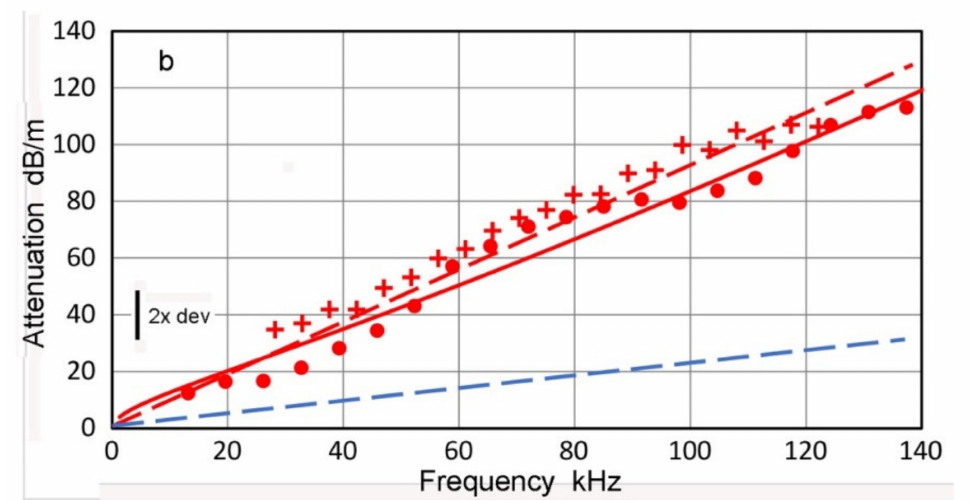
Figure 16. ( a ) Observed α –S o values for 4.3-mm PVC plate along with the calculated attenuation and dashed lines for α L and α T . Two test series are plotted using blue symbols. Both used Olympus V101 Tx and KRN-BB-PC Rx, with short-pulse excitation. Vertical bar shows 2 × dev. ( b ) Observed α –A o values for 4.3-mm PVC plate along with the calculated attenuation and dashed lines for α and α T . Both series are plotted using red symbols and used NDT C16 Tx at 60 ◦ incident angle and KRN-BB-PC Rx. All with short-pulse excitation. Vertical bar shows 2 ×